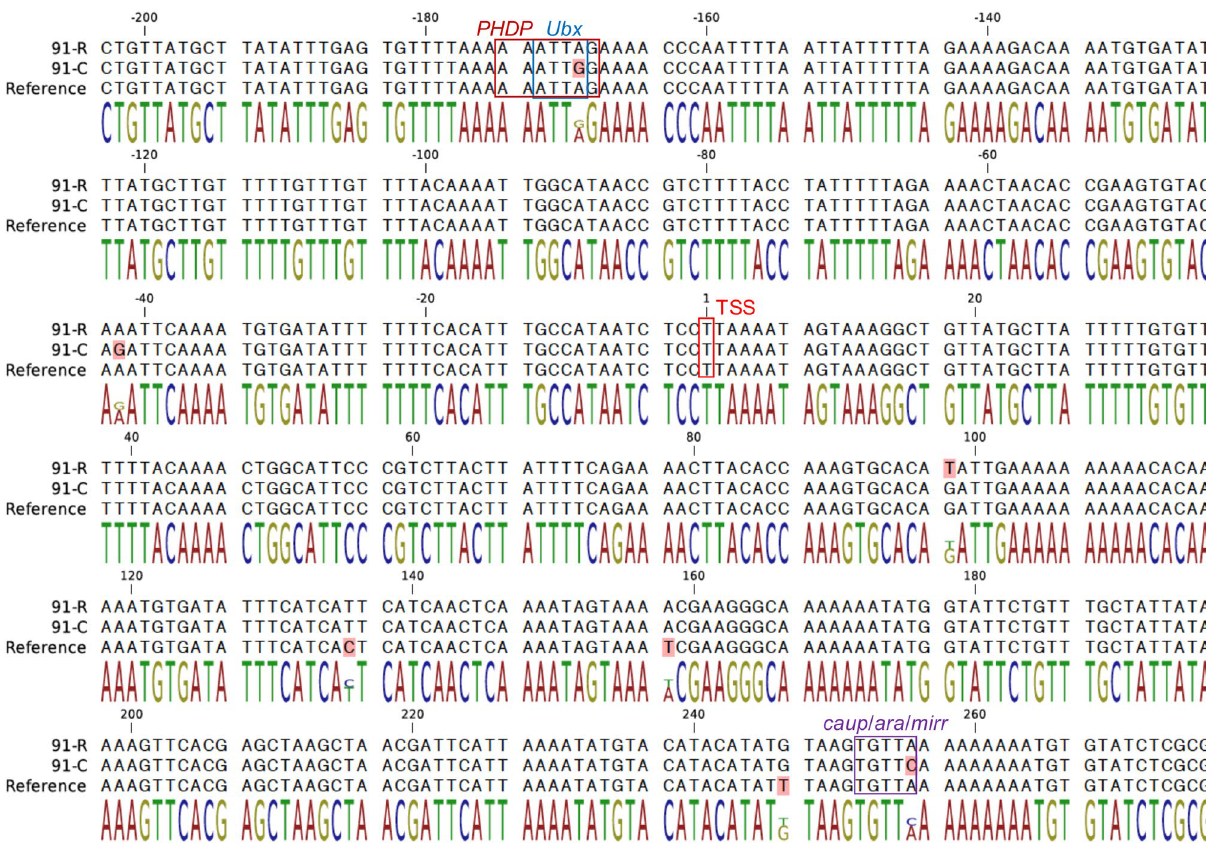
Figure 5. The position of putative transcription factor binding sites within 200 bp up-stream and 280 bp down- stream of the predicted miR-310s cluster transcription start site (TSS). The transcription factor binding sites are boxed. The polymorphisms among three strains are shaded in